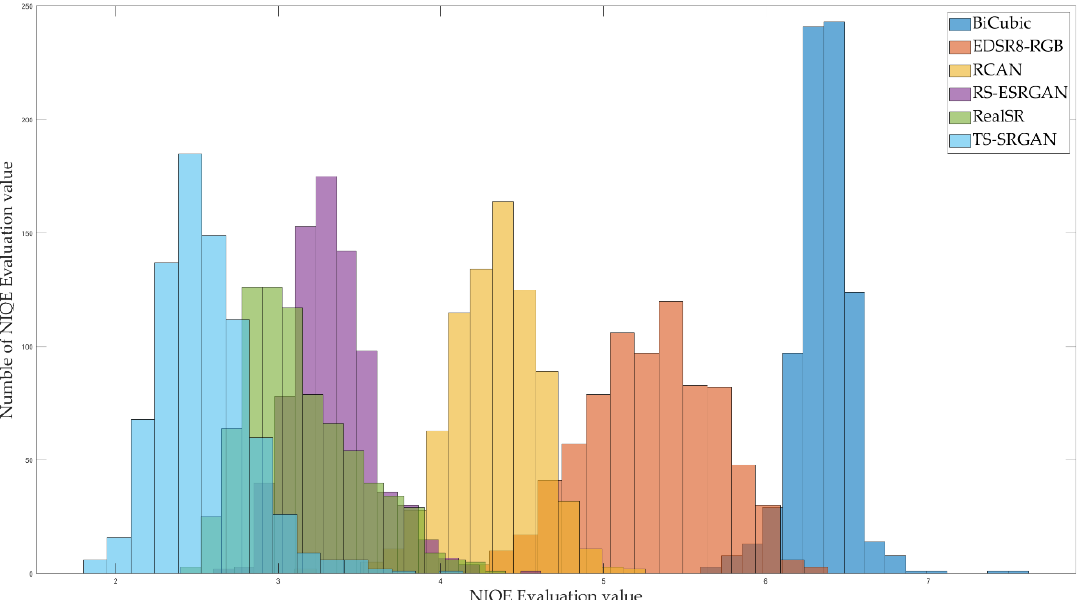
Figure 11. Distribution of evaluation values of NR-IQA metric NIQE.